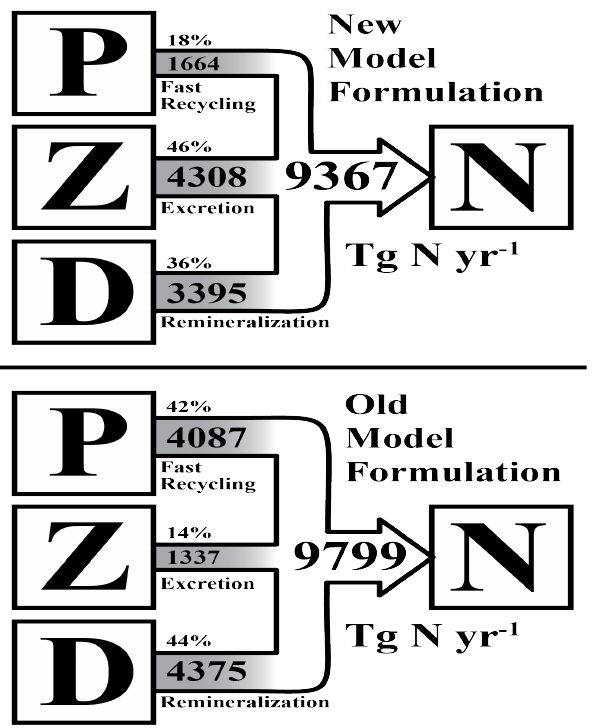
Fig. 25. Comparison between model versions of the pathways of nitrate regeneration. Values are from globally integrated